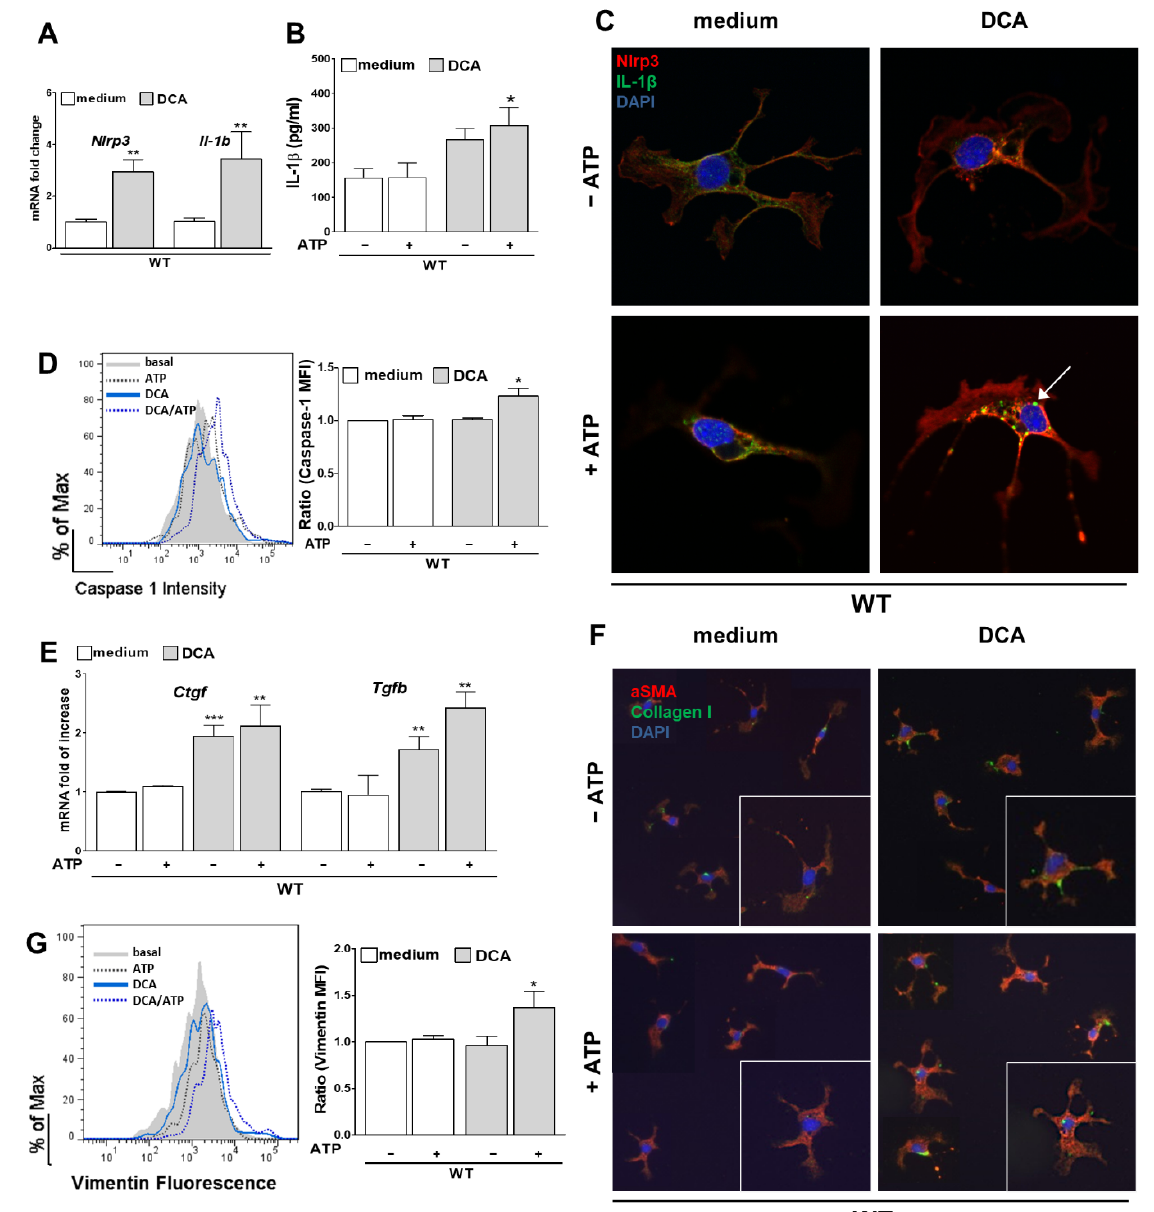
Figure 4. DCA activates the NLRP3 inflammasome in HSC leading to early fibrosis. Stimulation with DCA (+ ATP) activates the NLRP3 inflammasome in HSC as indicated by elevated mRNA levels of Nlrp3 and Il-1b ( A ), increased levels of IL-1 β in the supernatant ( B ) and activity of Caspase-1 ( D ). Microscopically, not only an upregulation of NLRP3 and formation of IL-1 β vesicles were observed after immunofluorescent staining ( C , arrow) but also a change of morphology to a more active, star-like shape with higher deposition of Collagen I ( F ). Upregulated mRNA levels of Ctgf and Tgfb ( E ) and an increase of the mean fluorescence intensity of Vimentin ( G ) as an early fibrotic protein marker confirmed this effect after DCA (+ATP) stimulation. * p < 0.05; ** p < 0.01; *** p <